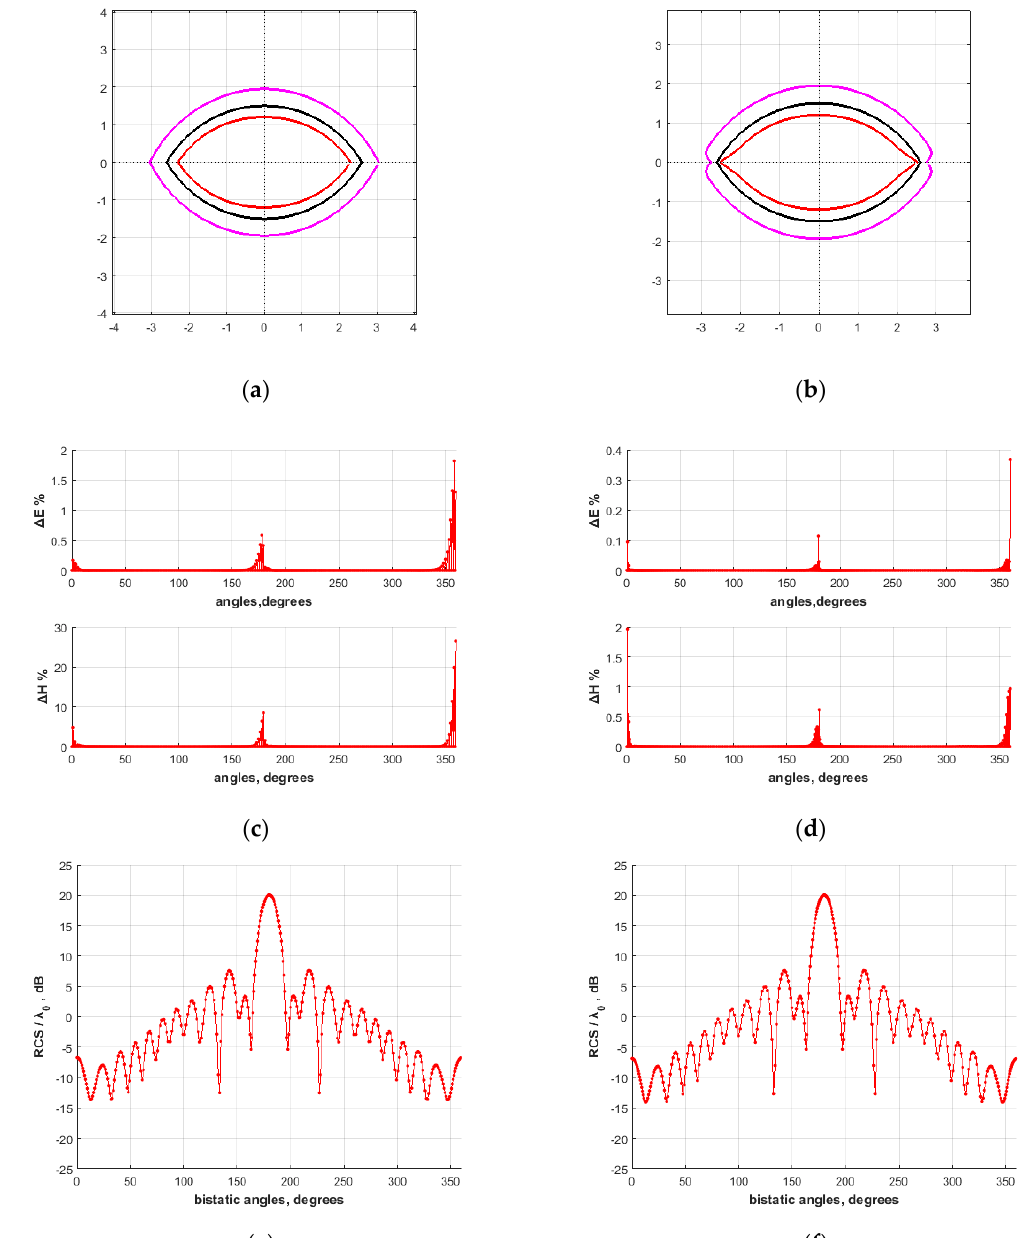
Figure 11. Mediocre arc displacement d = 0.5 ρ = 1.5 λ : ( a ) geometry and conformal auxiliary surfaces; ( b ) geometry and improved auxiliary surfaces; ( c ) conformal ∆ E and ∆ H error; ( d ) improved ∆ E and ∆ H error; ( e ) conformal RCS; and ( f ) improved RCS.